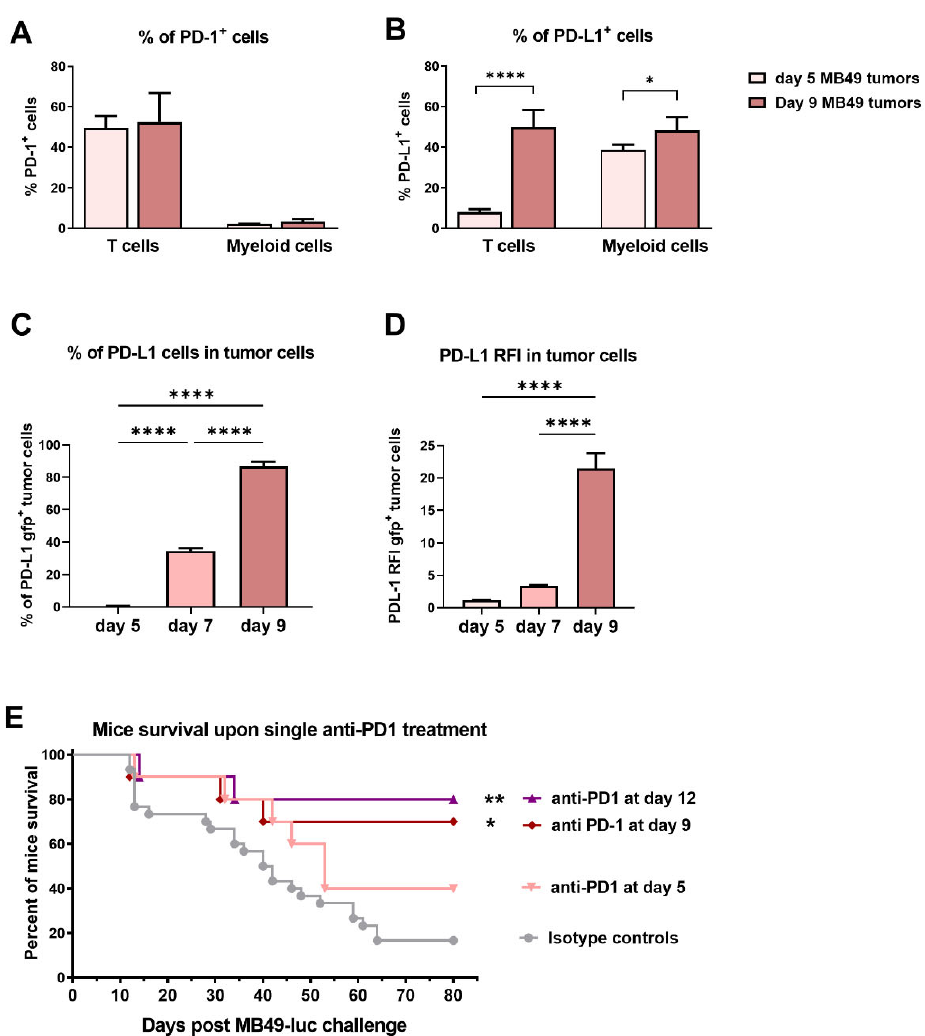
Figure 2. Expression of the immune checkpoint PD ‐ 1 and PD ‐ L1 and anti ‐ PD ‐ 1 treatment efficacy. MB49 ‐ luc cells ( A , B and E ) or MB49 ‐ gfp cells ( C , D ) were intravesically instilled in the mouse blad ‐